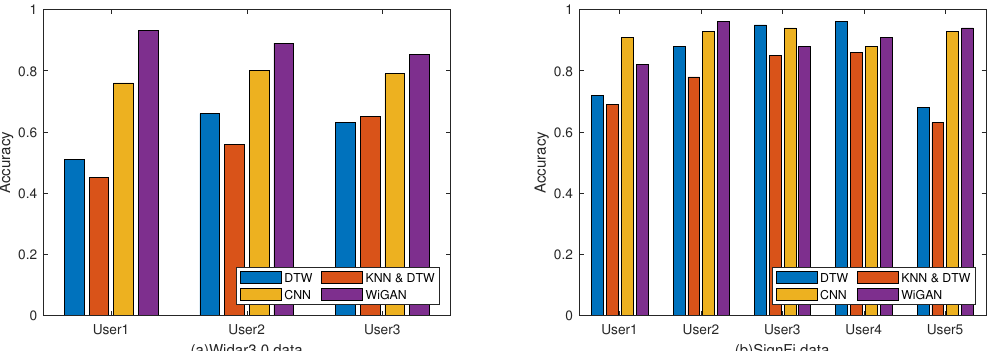
Figure 7. Comparison of the recognition accuracy of different users on the two data. ( a ) Widar3.0 data. ( b ) SignFi